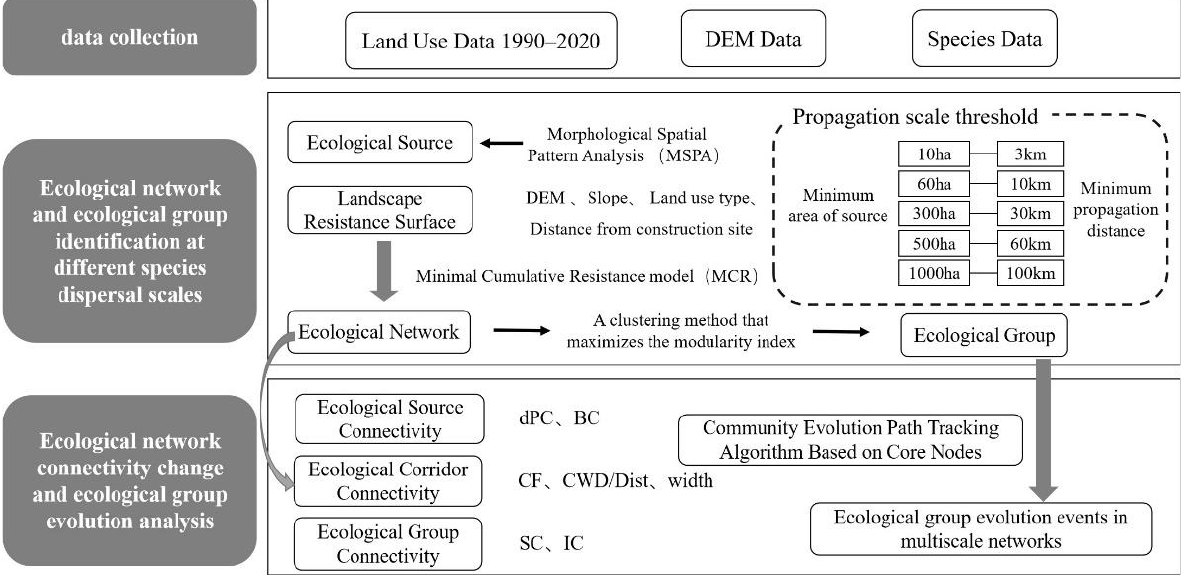
Figure 1. Technology Roadmap.